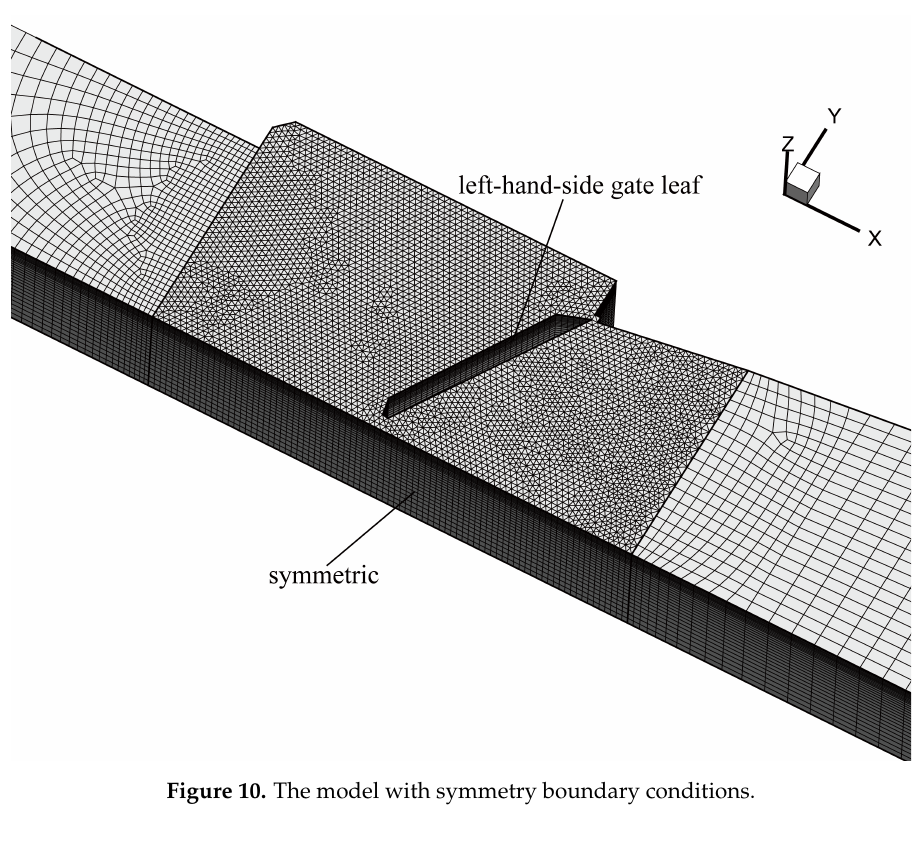
Figure 10. The model with symmetry boundary conditions.